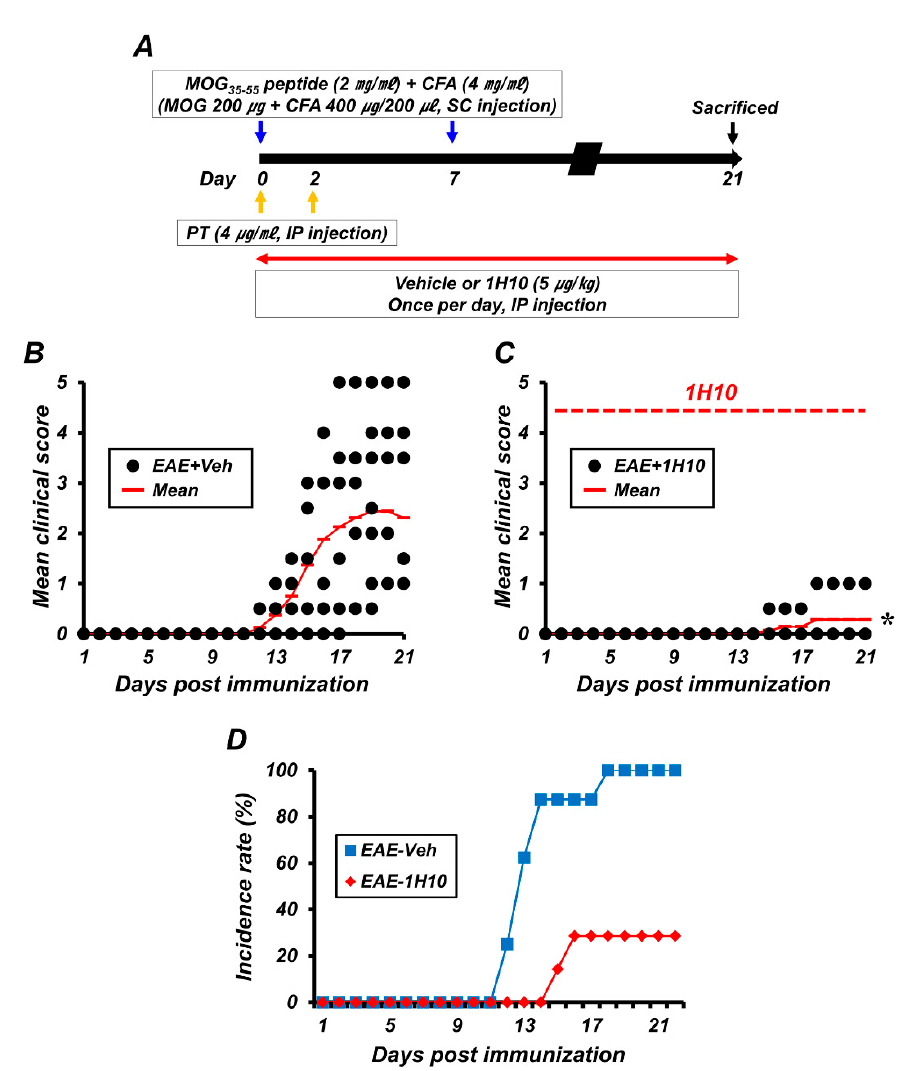
Figure 2. 1H10 ameliorates the clinical signs and progression of myelin oligodendrocyte glycoprotein 35-55 (MOG 35-55 )-induced experimental autoimmune encephalomyelitis (EAE). ( A ) Timeline showing the experimental design. 1H10 was intraperitoneally administered once per day for the entire experimental course. Mice were then killed on day 21 following the initial immunization. ( B,C ) EAE clinical scores are shown for both vehicle ( B ) and 1H10 groups ( C ) (mean ± SEM; n = 7–8 per group). @, #, and *: p < 0.05. vehicle-treated EAE mice (repeated measure ANOVA; Day: F = 14.691, p < 0.001; Group: F = 11.082, p = 0.001; Day × group interaction: F = 9.429, p < 0.001). ( B ) Percentage disease incidence of vehicle- or 1H10-treated immunized mice (mean ± SEM; n = 7–8 per group).